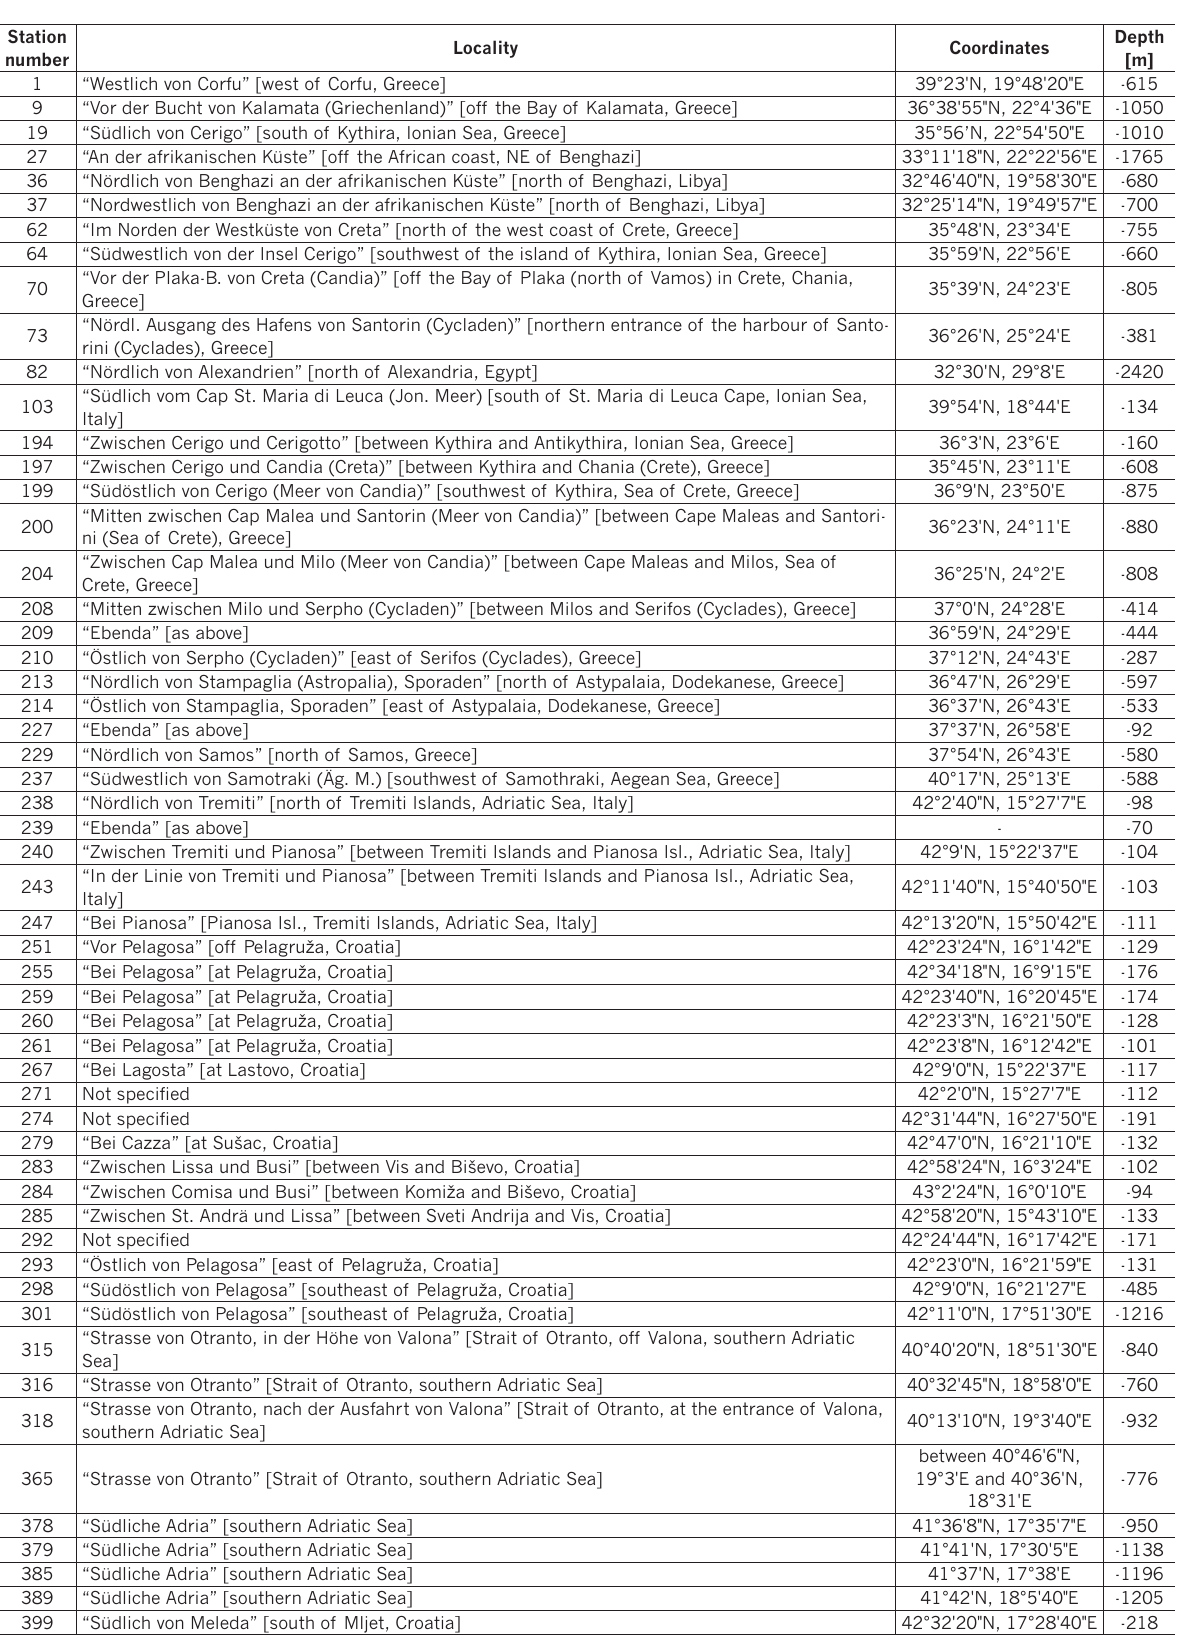
Table 2 . Stations of the “Pola” expeditions to the Eastern Mediterranean Sea listed by Sturany (1896) where molluscs were